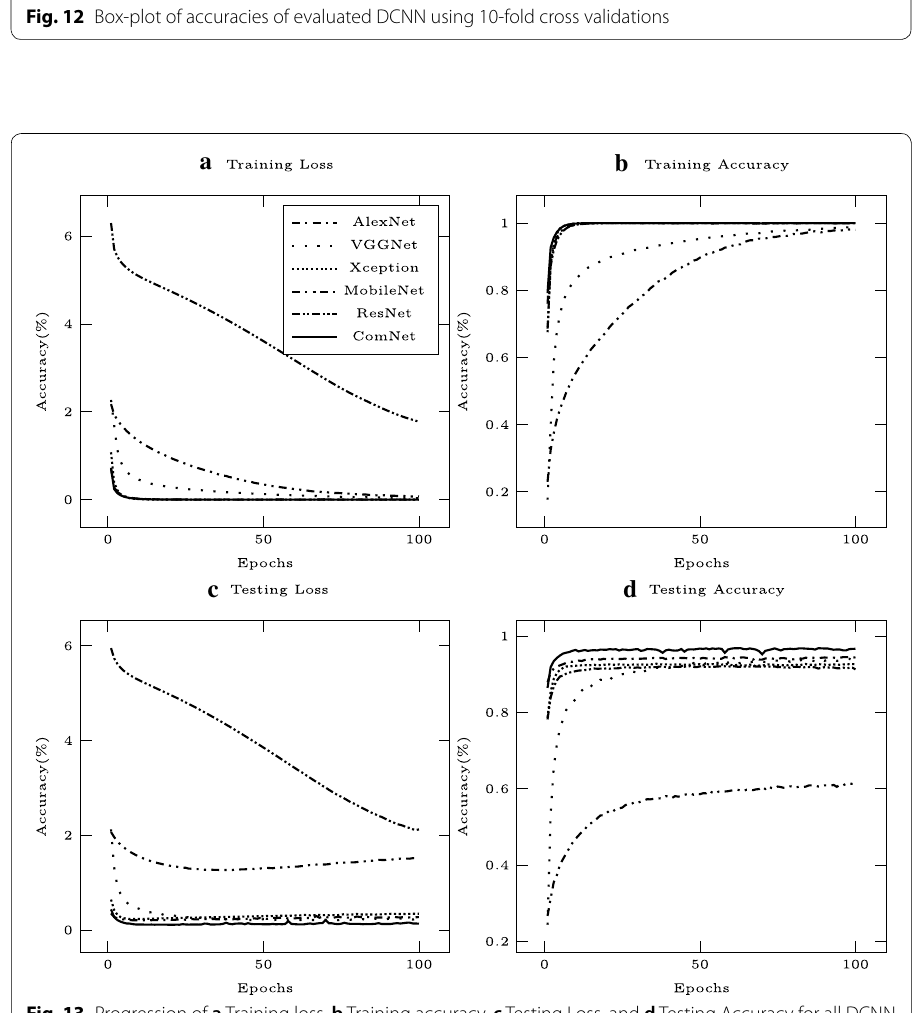
Fig. 13 Progression of a Training loss, b Training accuracy, c Testing Loss, and d Testing Accuracy for all DCNN architectures on Plantvillage. The results are the average values of 10-fold cross